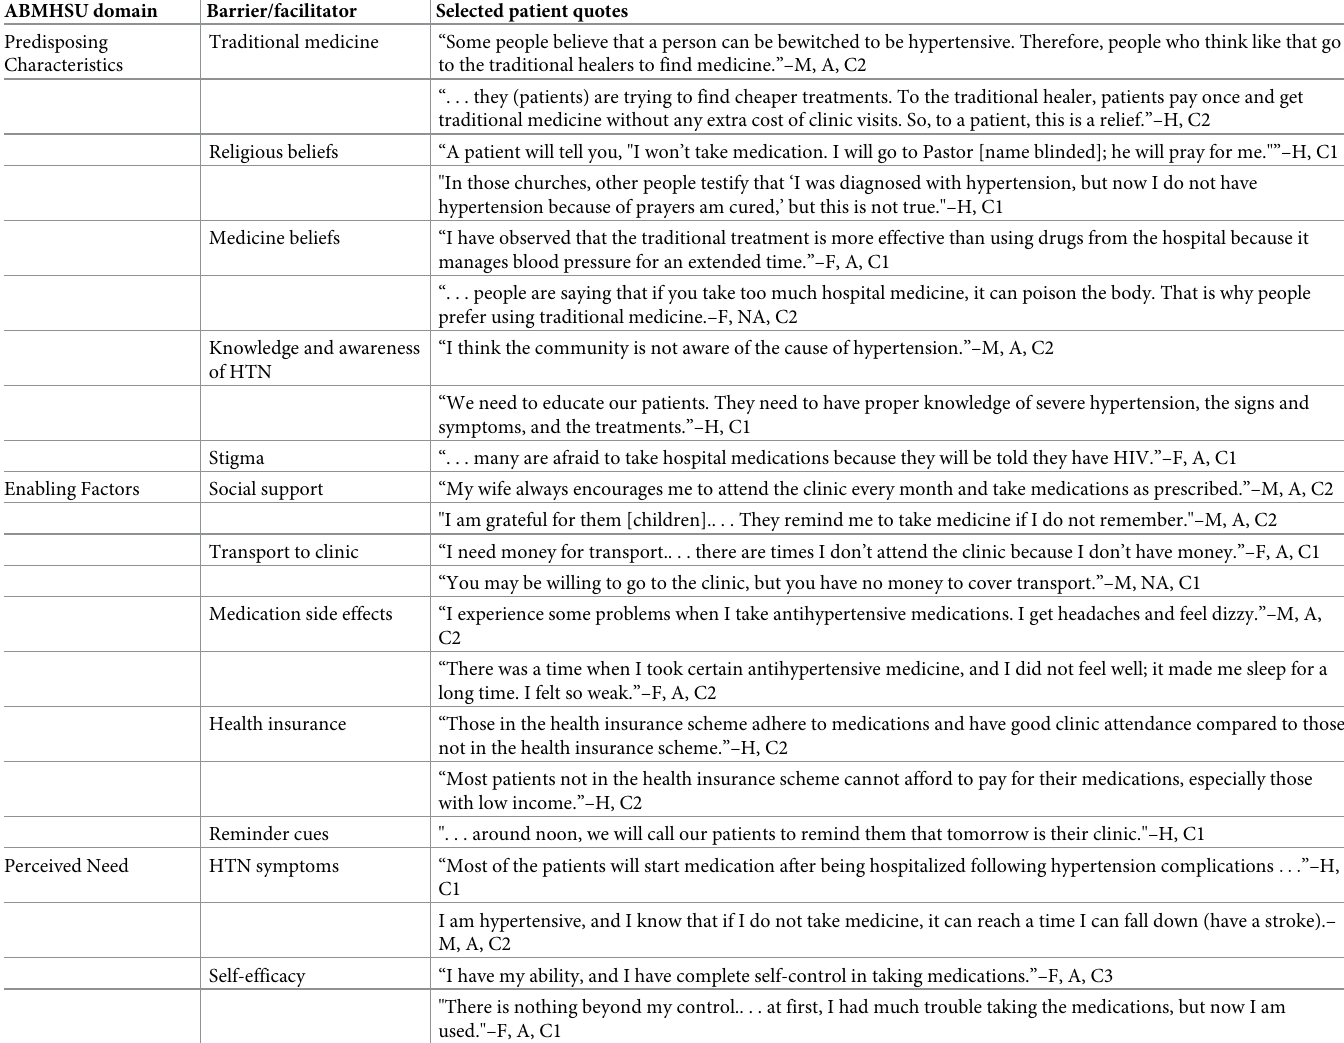
Table 3. Patient-level barriers/facilitators to clinic attendance and medication adherence organized according to the domains of the Andersen’s behavioral model of health services use. ABMHSU